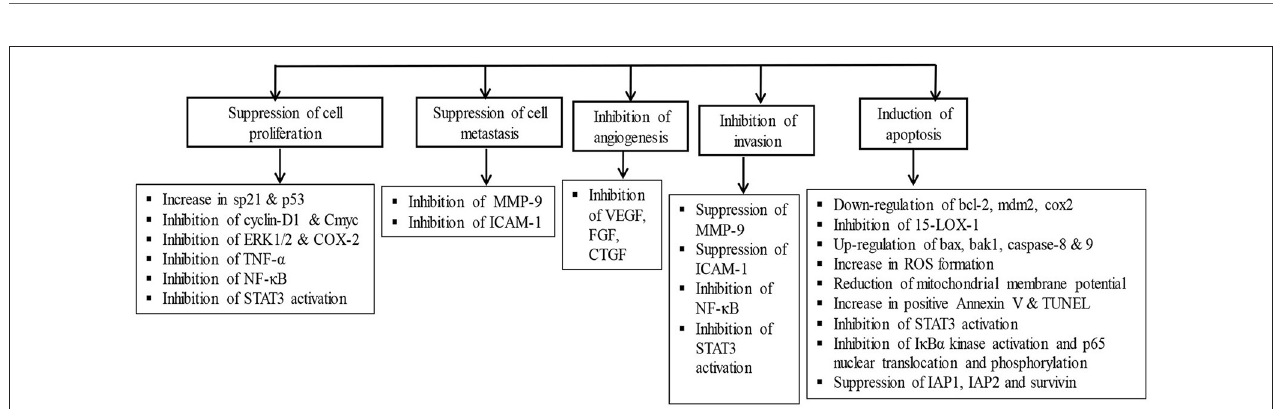
FIGURE 3 | The chemopreventive and anticancer mechanism of asiatic acid in different cancer cell lines and animal studies. enhanced apoptosis and reduced migration and invasion of cells by activating apoptotic proteins Bcl-2, Bax, c-Myc, and caspase-3 and inhibiting MMP-2 and -9. AA upon microbial transformation provides novel and potent derivatives which exhibit cytotoxic effects in several human cancer cell lines